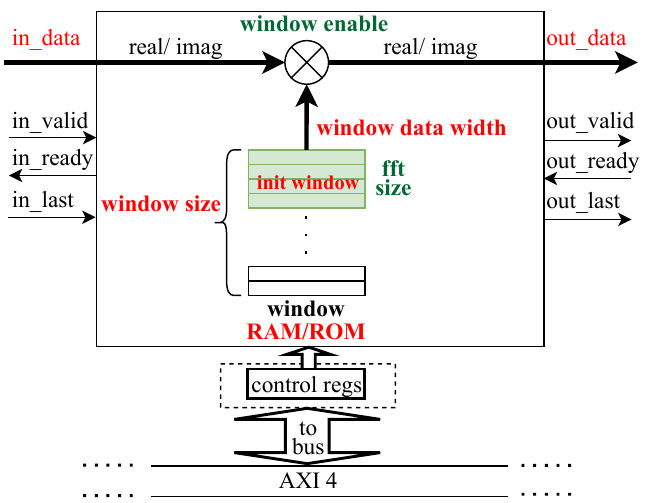
Figure 7. Diagram of the windowing block. Parametrized options are written in red; control registers are written in